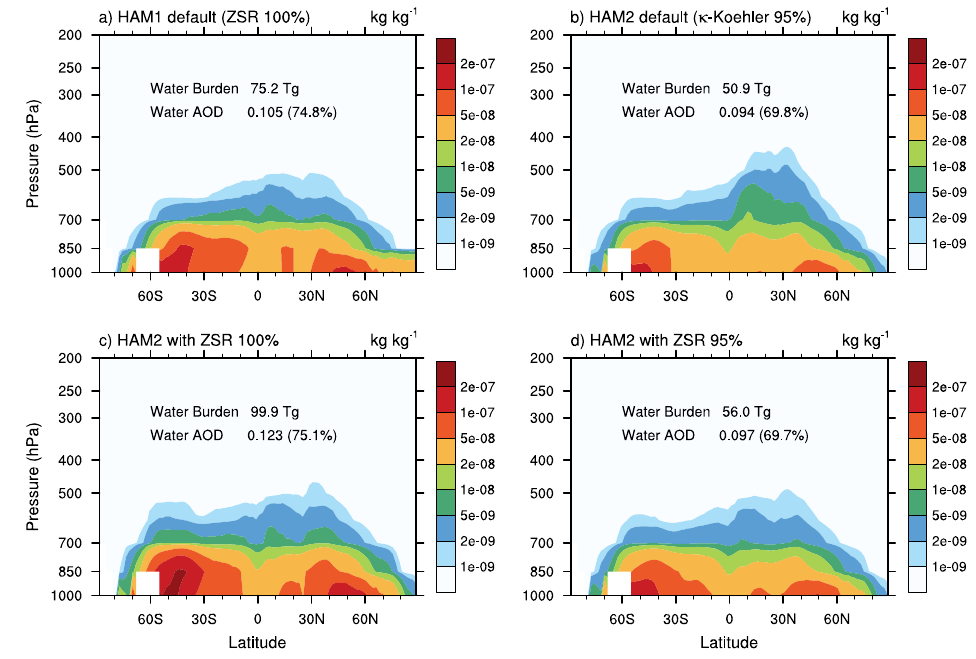
Fig. 4. Zonal and annual mean aerosol water content in (a) default HAM1, (b) default HAM2, and (c) – (d) two simulations performed with HAM2 but the old water uptake scheme. Different RH ceilings are used in (c) and (d) in the calculation of water uptake by the accumulation and coarse mode particles. Numbers noted in the figure are the annual mean global total aerosol water content as well as the absolute and relative contributions of aerosol water to the aerosol optical depth (AOD). Further details can be found in Sect.